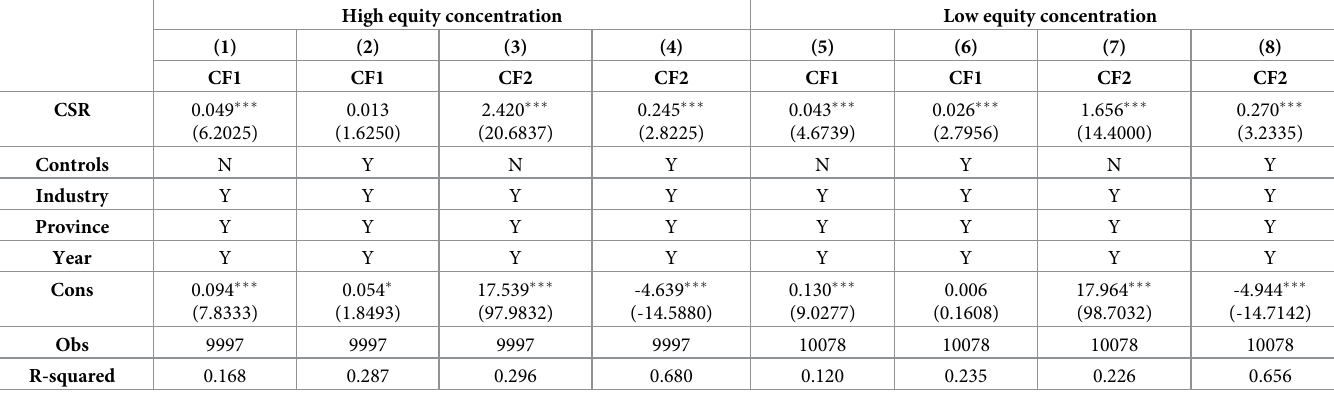
Table 5. Sample regression of high ownership concentration and low ownership